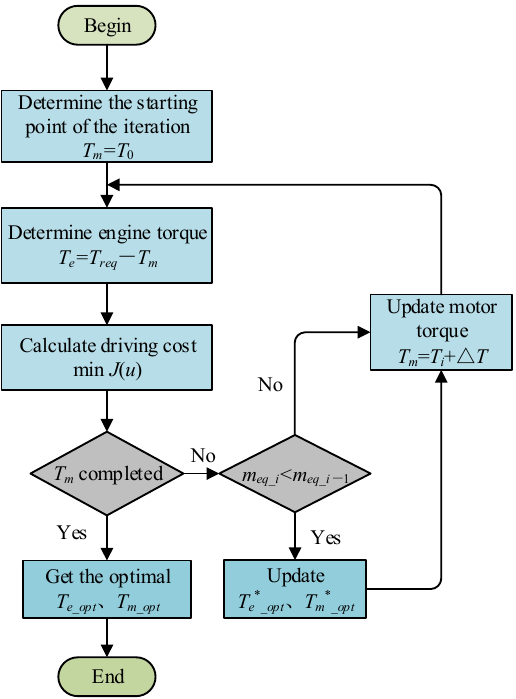
Figure 12. Flowchart of procedure for optimal torque.